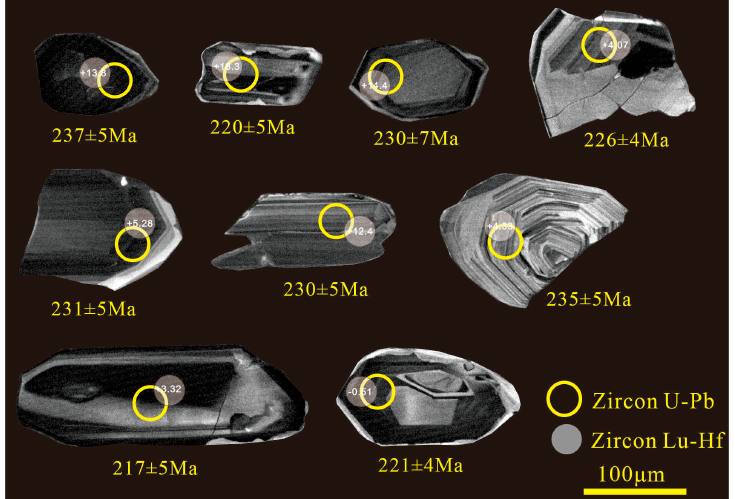
Figure 3. Cathodoluminescence (CL) images of typical zircons from the Laocheng appinite. Circles indicate the location of LA-MC-ICP MS Hf analyses; the numbers in circles refer to the ε Hf ( t ) values. All ε Hf ( t ) values of the granites were calculated according to their crystallization age.